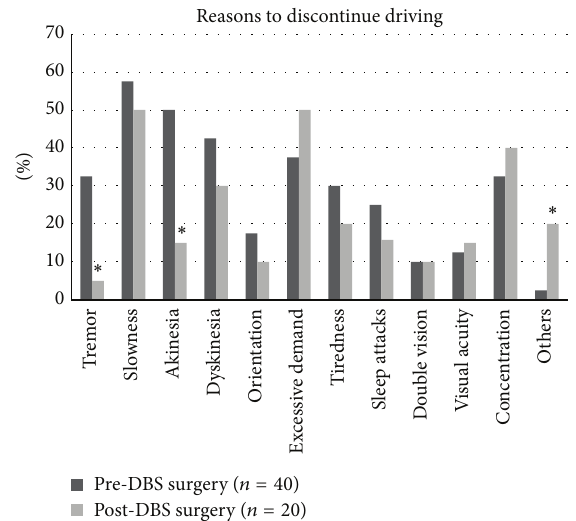
Figure 1: Parkinson’s disease-related symptoms responsible for quitting driving. Symptoms related to Parkinson’s disease and mentioned by the patients to be responsible alone or in combination for cessation of driving before or after DBS surgery are shown as occurrence in percentage (%). Significant different frequencies are labeled with an asterix ( ∗